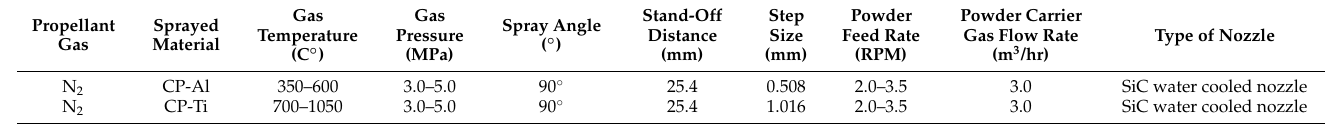
Table 2. CS process